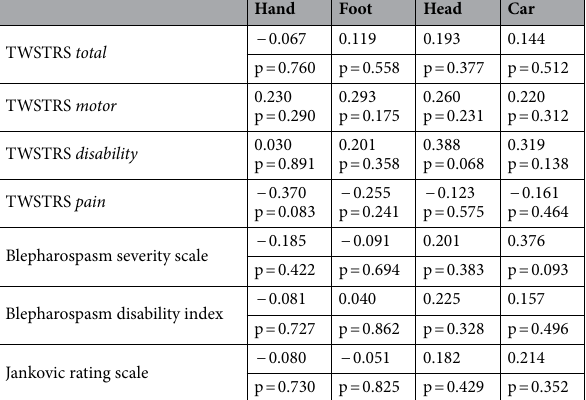
Table 5. Correlations between reaction time in the mental rotation task and symptom severity of focal dystonia (Spearman coefficients and corresponding p values). TWSTRS: Toronto Western Spasmodic Torticollis Rating